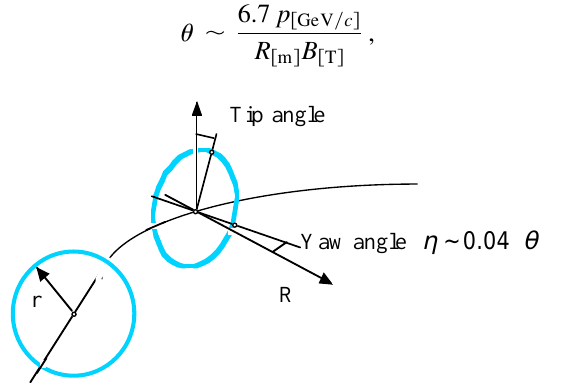
FIG. 11. (Color) The tipped and turned coils geometries.